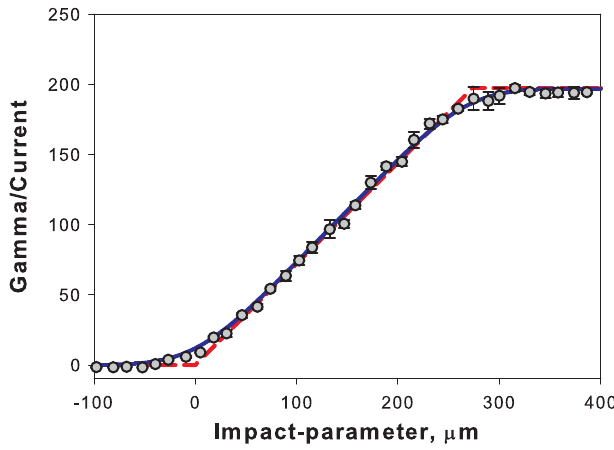
FIG. 3. (Color) The dependence of air Cherenkov counter signal vs impact parameter (points); single electron approach (dashed red line); Gaussian bunch ( (cid:8) y ¼ 29 : 35 (cid:1) m ) approach (solid blue line).